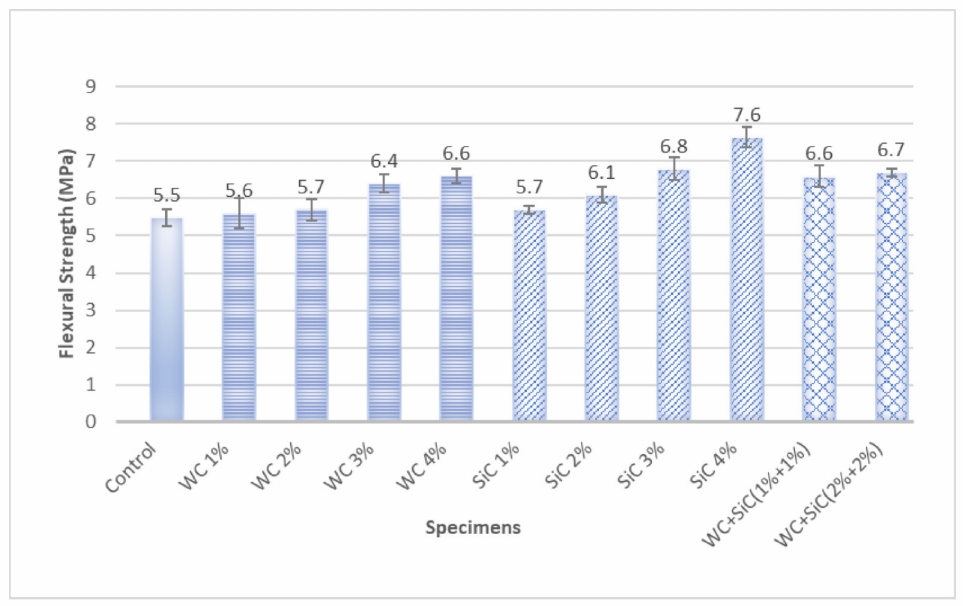
Figure 6. Flexural Strength of Specimens at 28